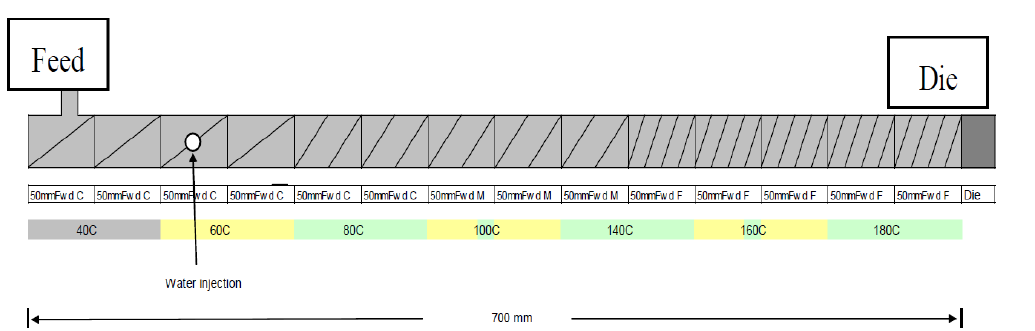
Figure 1. Schematic diagram of screw configuration of the extruder, the angle on the schematic represents screw pitch from the feed at the left hand side to the die on the right hand